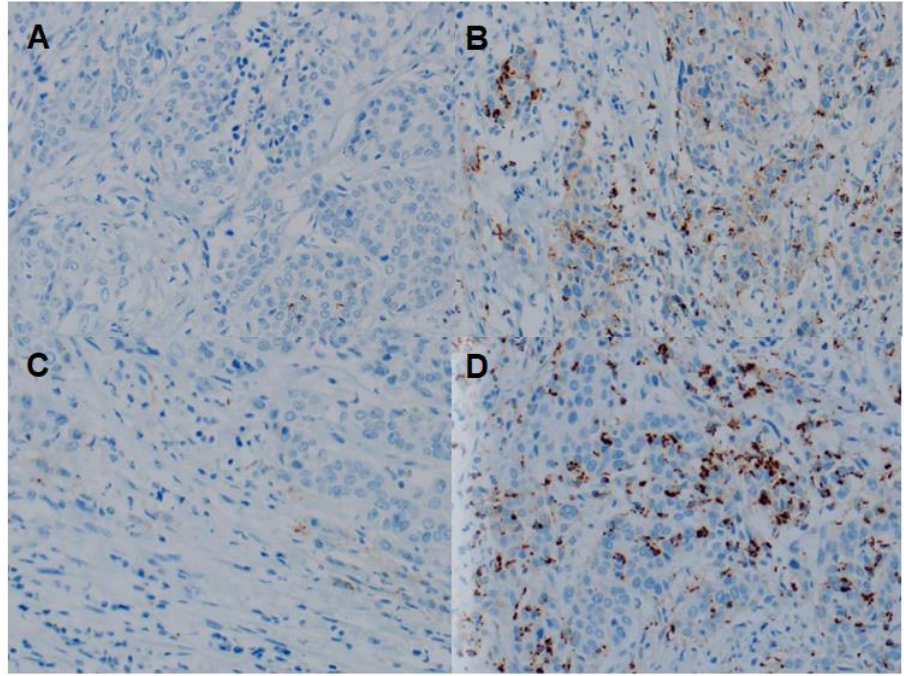
Figure 2. Representative images of PD-L1 expression in TICs using the VENTANA (SP142) immunohistochemistry assay. ( A ) Negative expression of PD-L1 in MPUC, ( B ) Positive expression of PD-L1 in MPUC. ( C ) Negative expression of PD-L1 in UCSD, ( D ) Positive expression of PD-L1 in UCSD. All images are ×200 magnification. PD-L1, programmed death-ligand 1; TICs, tumor-infiltrating immune cells; MPUC, micropapillary variant of urothelial carcinoma; UCSD, urothelial carcinoma with squamous differentiation.